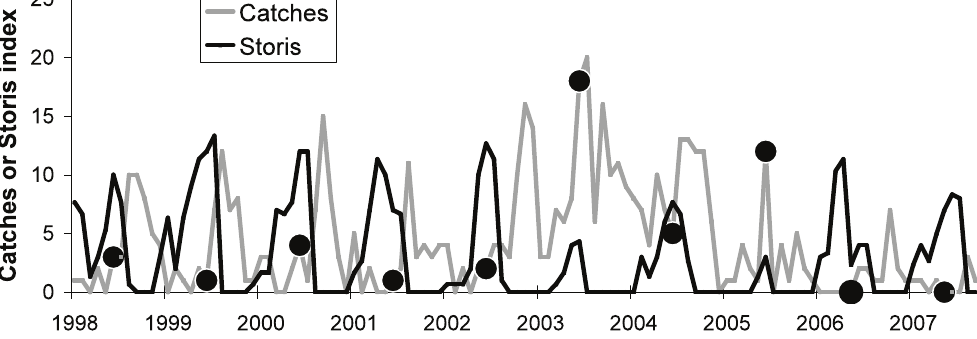
Fig. 6. The monthly reported catch of harbour seals in South Greenland (Anon. January 1998–September 2007) and a monthly index of drift ice “Storis” (Fabricius et al. 1995; Rosing- Asvid 2006). Catches in June are marked with a (cid:2) .